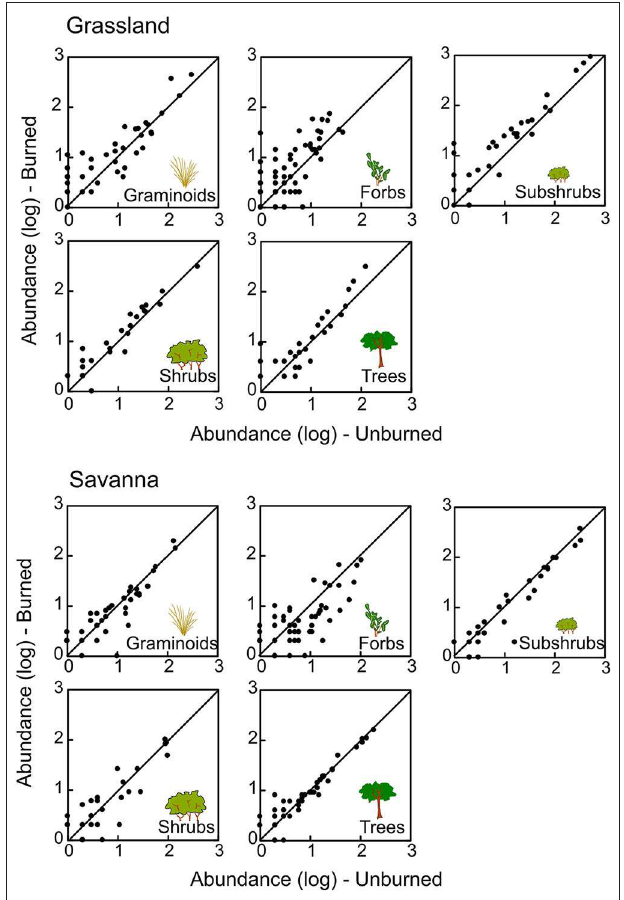
FIGURE 4 | Abundance (log 10 -transformed data) of different plant groups sampled in unburned and burned plots of grassland and savanna. Each point represents one species. The line represents the 1:1 equivalence line, at Santa Bárbara Ecological Station, state of São Paulo, Brazil.